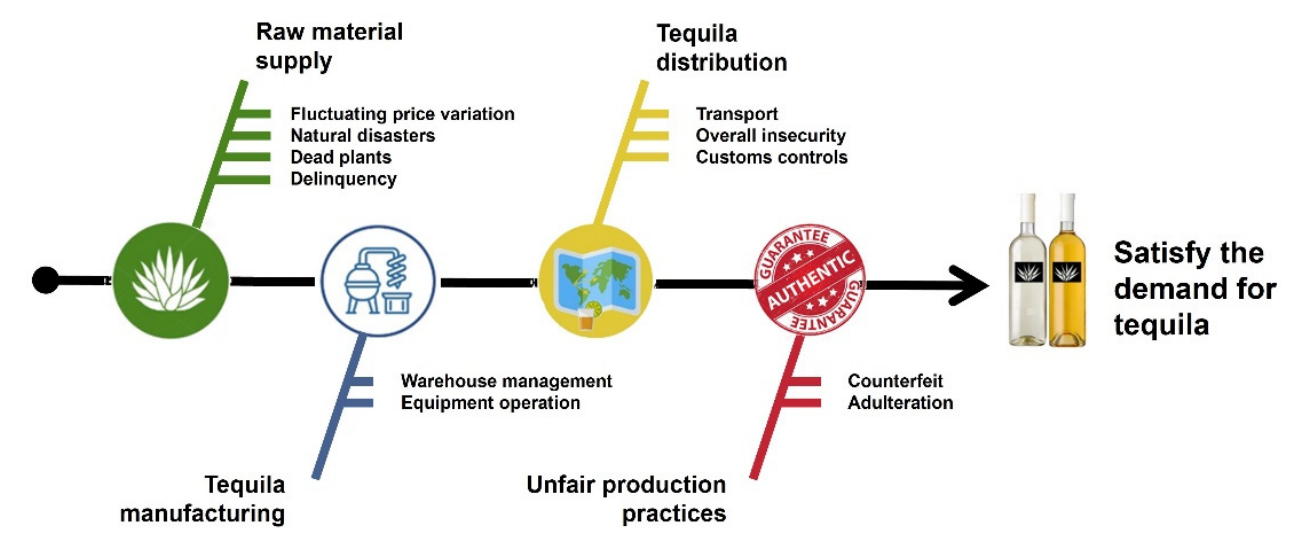
Figure 2. Risk analysis of the Tequila supply chain to satisfy the current demand.